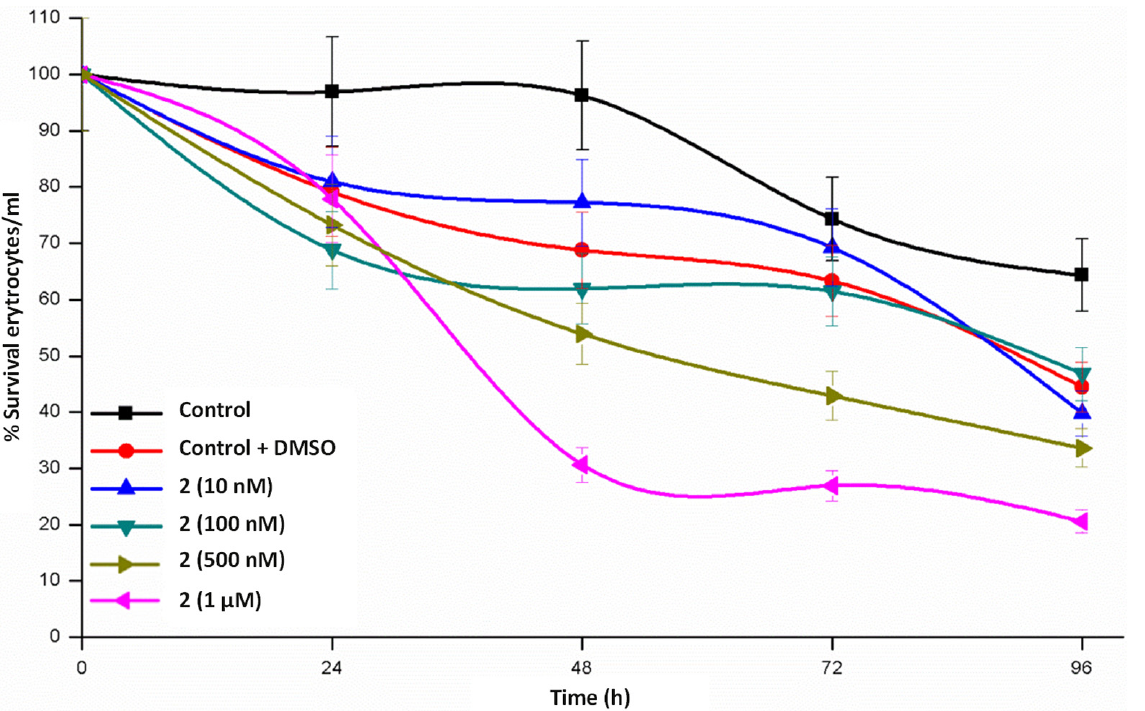
Figure 5. Time course study of erythrocyte survival in the presence of Zn 2 (L Ph ) 2 · 2H 2 O 2 dihelicate.